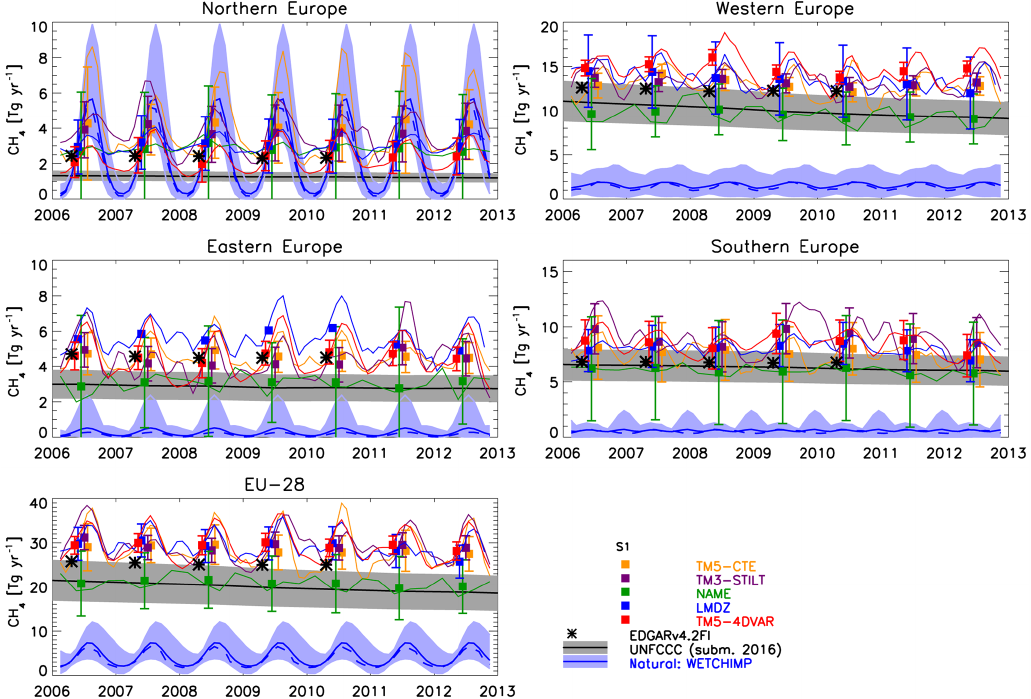
Figure 4. Same as Fig. 3a but including seasonal variation of CH 4 emissions derived from the inversions (S1 only; 3-monthly running mean, coloured solid lines), and seasonal variation of wetland CH 4 emissions from the WETCHIMP ensemble of seven models (mean, blue solid line; median, blue dashed line; minimum–maximum range, light-blue range; 3-monthly running